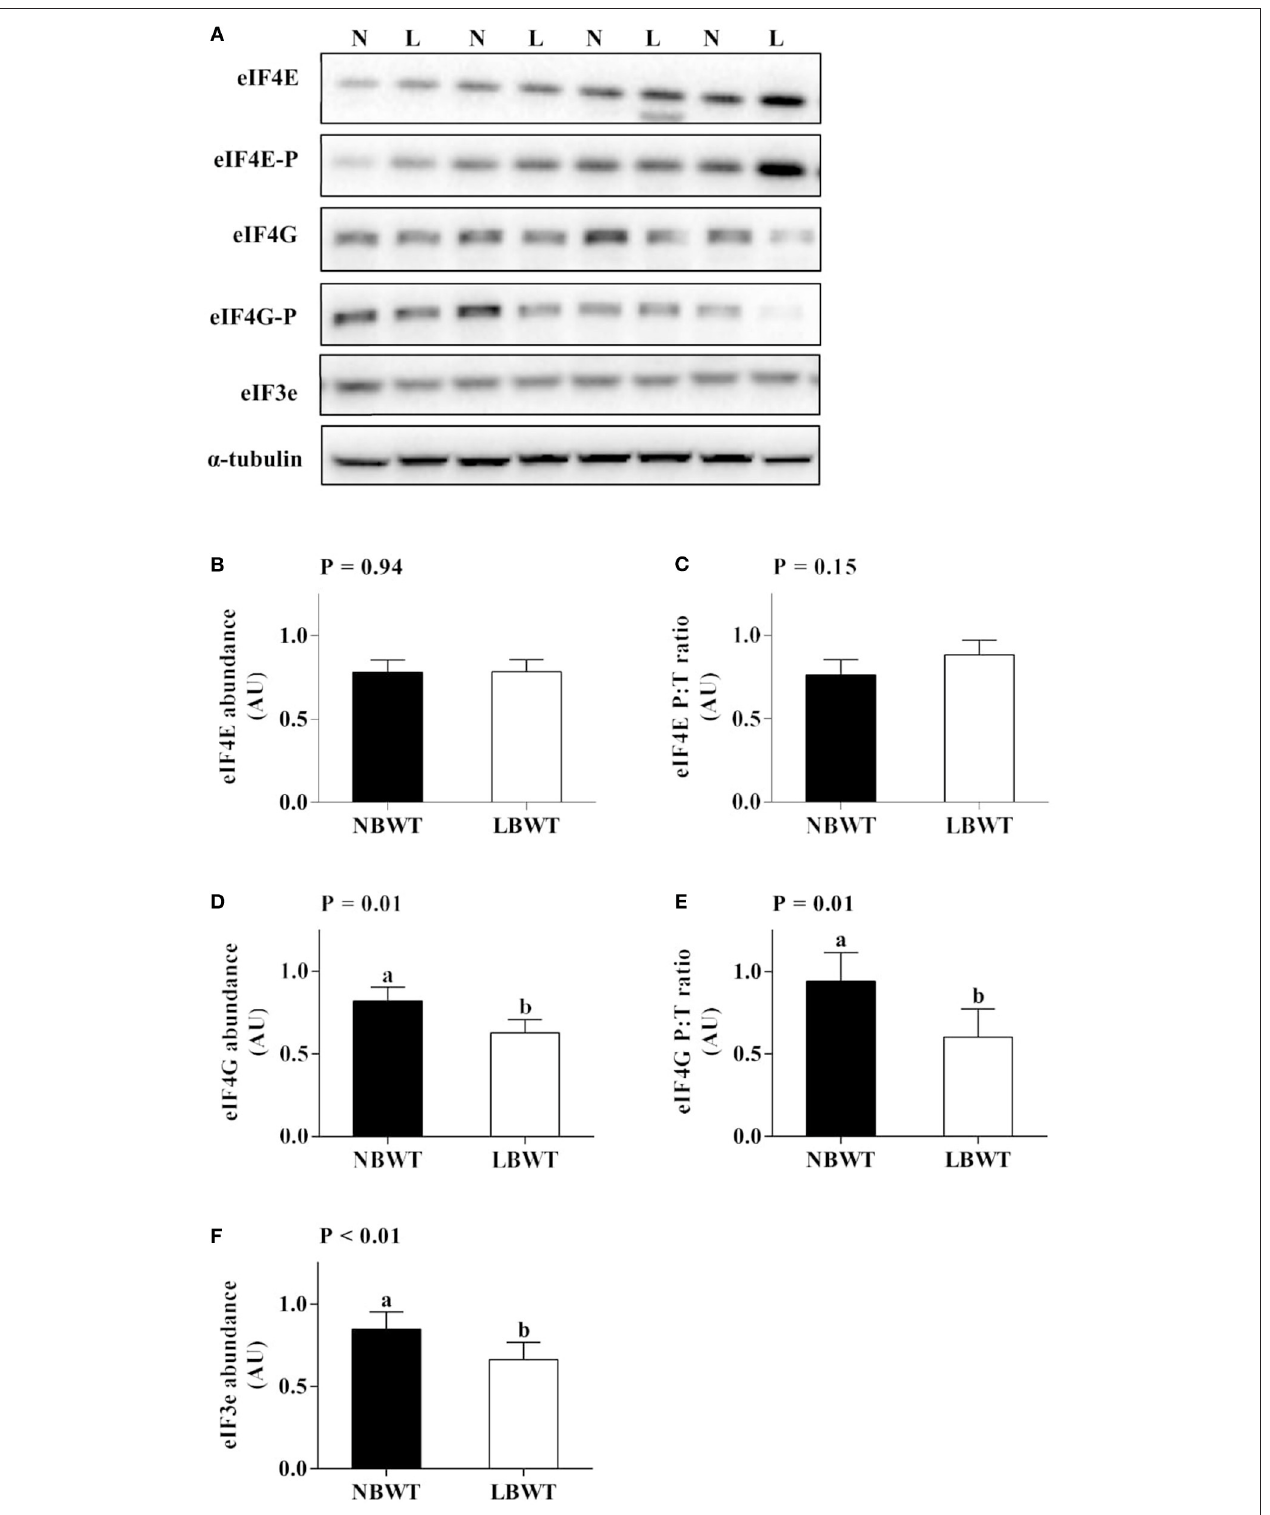
FIGURE 8 | Translation initiation signaling in longissimus dorsi muscle of low-birth-weight (LBWT) and normal-birth-weight (NBWT) neonatal pigs. (A) : Representative western blots from four pairs of LBWT and NBWT pigs (N, NBWT; L, LBWT). (B – F) : Protein abundance and phosphorylation of eIF4E, eIF4G, and protein abundance of eIF3e. Abundance was normalized to α -tubulin and phosphorylation normalized to the corresponding non-phospho-proteins. Results are means ± SE. n = 12. Values with different letters differ significantly ( P ≤ 0.05).